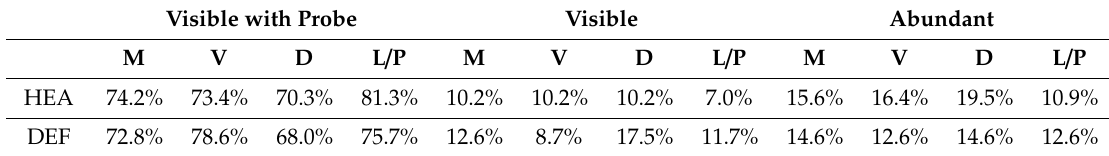
Table 3. Modified Plaque Index, 12